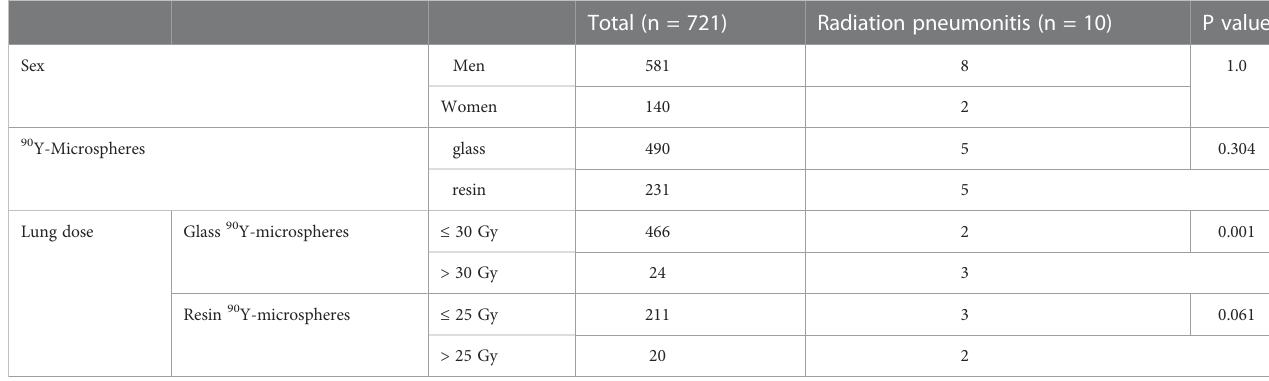
TABLE 3 Baseline characteristics in 721 patients whose lung dose was able to be calculated.